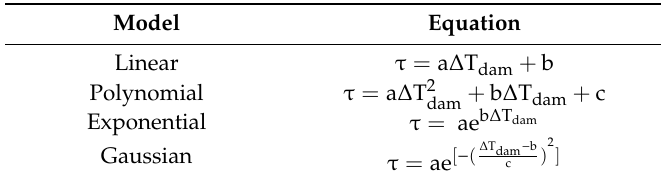
Table 1. Models adopted to test the parametrization of cloud transmissivity ( τ ) by means of the daily temperature range acquired at the o ff -glacier Frodolfo dam station ( ∆ T dam